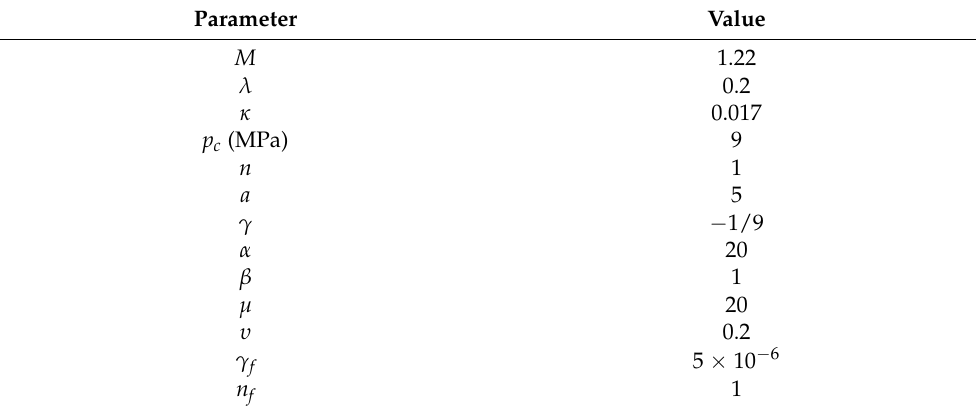
Table A6. Model Parameters adopted for Case 1 in Figure 12 and Case 2 in Figure 13.